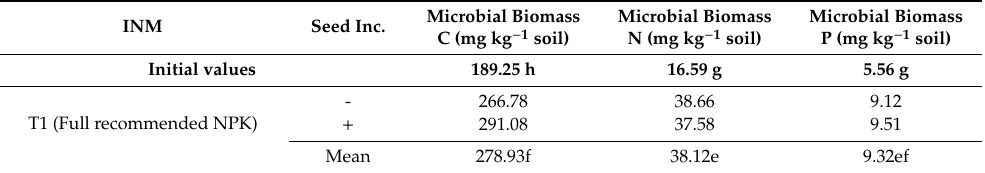
Table 4. E ff ects of di ff erent integrated nutrient management (INM) with ( + ) and without ( − )